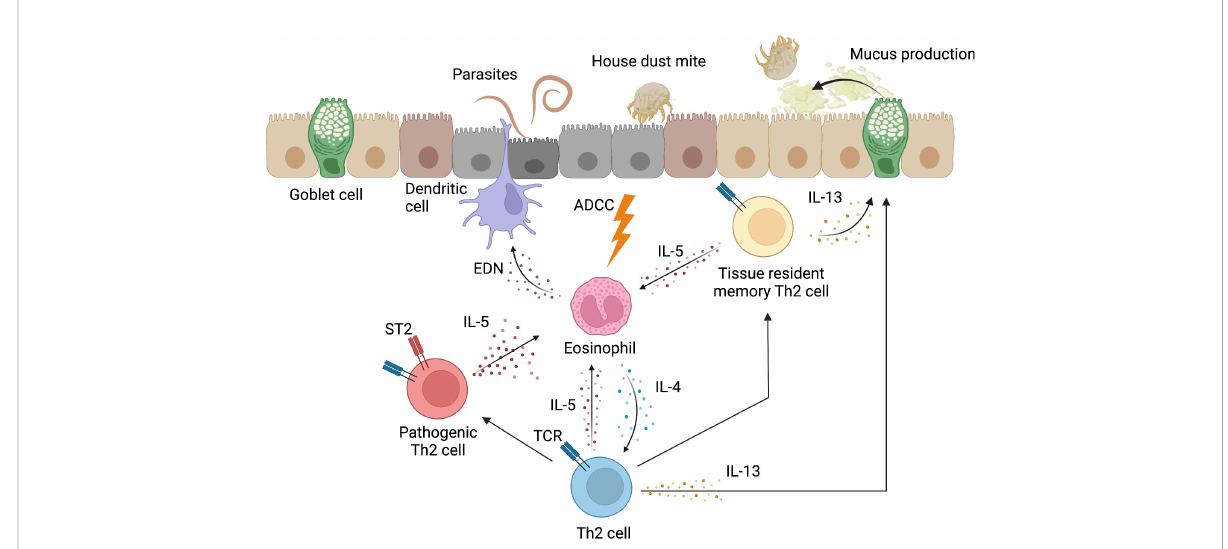
FIGURE 2 In fl ammatory response induced by Th2 cells. In in fl ammatory tissues, Th2 cells induce an in fl ammatory response to eliminate antigens. Th2 cells recruit eosinophils to the site of in fl ammation through IL-5 production and promote their survival. Eosinophil-derived neurotoxin (EDN) acts as a chemoattractant and activator of dendritic cells. Eosinophils can also kill some parasites via the classical antibody-dependent cytotoxicity (ADCC) mechanism. In addition, eosinophils promote the development of Th2 cells through the production of IL-4. In addition to the induction of eosinophilic in fl ammation by IL-5, Th2 cells produce IL-13, which induces mucus production from epithelial cells, including goblet cells, and promotes the elimination of allergens from epithelial tissues. The Th2 cell population contains pathogenic Th2 (Tpath2) cells that highly express ST2, which is the receptor for IL-33. Tpath2 cells become high-producers of IL-5 when activated by IL-33. Tissue-resident memory Th2 cells are differentiated from a portion of Th2 cells, and play an important role in type 2 in fl ammatory responses in local tissues through the production of Th2 cytokines, such as IL-5 and IL-13. This fi gure was created with